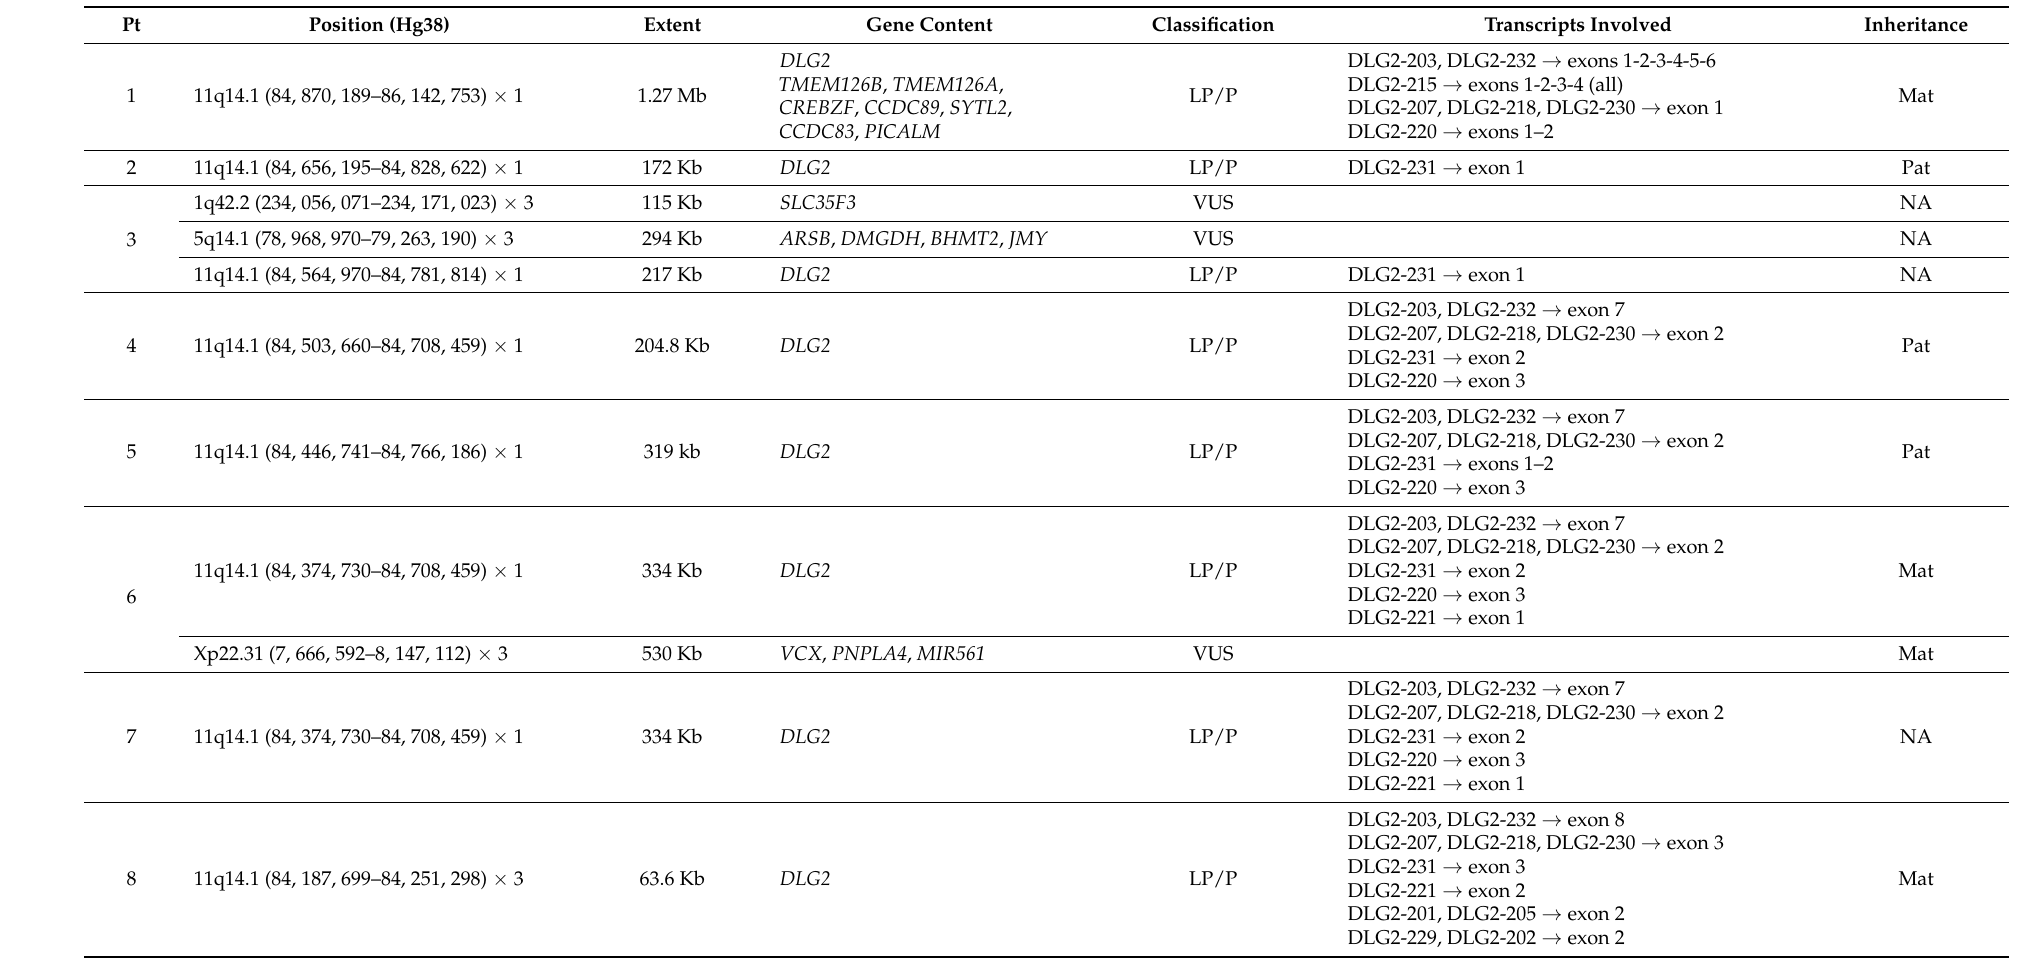
Table 2. Genetic data about the CNVs detected in the 8